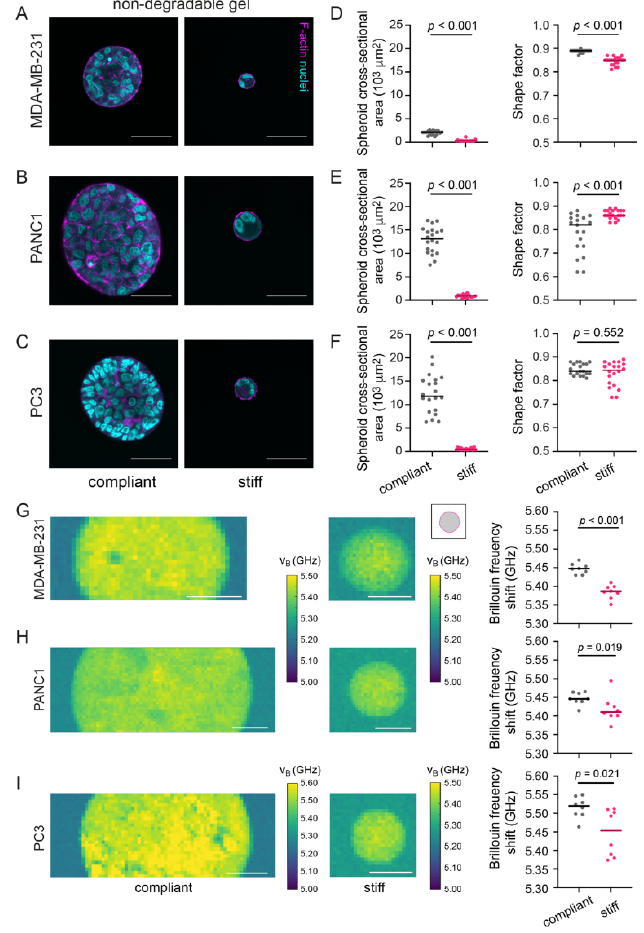
Figure 5. Invasive cancer cell lines (MDA-MB-231, PANC1 and PC3) do not form larger multicellu- lar tumor spheroids in stiff non-degradable hydrogels and show lower Brillouin frequency shifts. ( A – C ) Representative confocal images of MDA-MB-231 ( A ), PANC1 ( B ) and PC3 ( C ) spheroids grown in a compliant and stiff non-degradable gel. Spheroid cultures were stained for F-actin and nuclei using Phalloidin-TRITC and DAPI respectively. Scale bars correspond to 50 µ m. ( D – F ) Scatter plots showing cross-sectional area and number density of cells per unit area of respective spheroids in compliant and stiff non-degradable gels for the 3 cell lines on the left. n = 20 spheroids each. Lines indicate medians. ( G – I ) Representative Brillouin maps of MDA-MB-231 ( G ), PANC1 ( H ) and PC3 ( I ) spheroids formed in a compliant and stiff non-degradable gel (day 14). Scale bars correspond to 25 µ m. Right: Scatter plots showing Brillouin frequency shifts for respective cell types. Lines indicate medians. n = 8 spheroids each. A Mann–Whitney test was done for statistical analysis. p -values are given. Spheroids analyzed after 14 days of